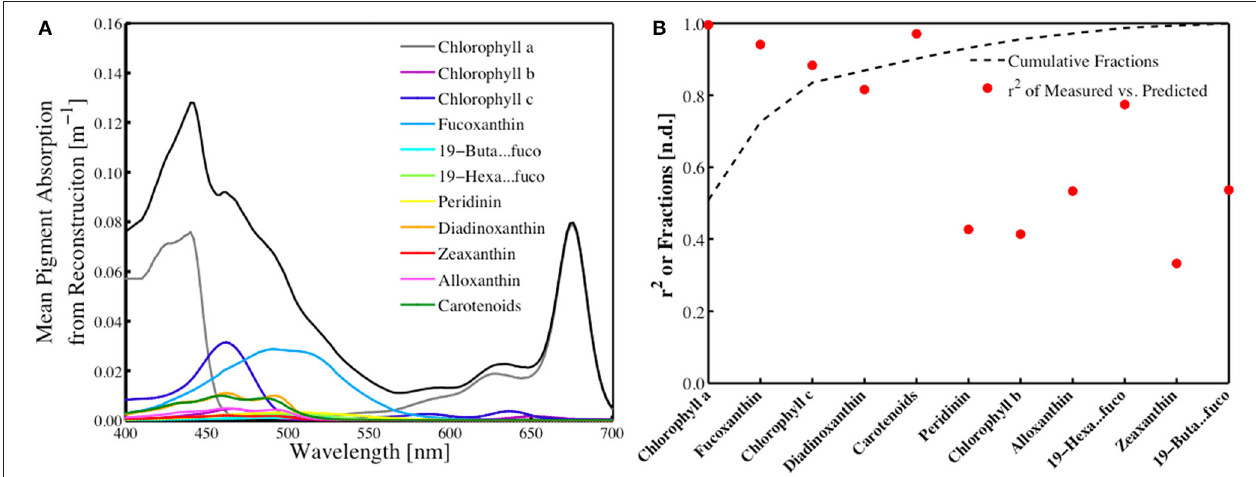
FIGURE 5 | (A) Reconstructed mean pigment-specific total absorption spectra (m − 1 ) of the different pigment biomarkers resolved in this study. The black line is the total absorption of all pigments. The lowest standard deviation values were insignificant, while higher standard deviation values for the pigments ranged from 0.0015 to 0.0686. (B) Cumulative fraction of the reconstructed pigment absorption to total absorption compared to the r 2 from the inverse model versus predicted HPLC pigments from